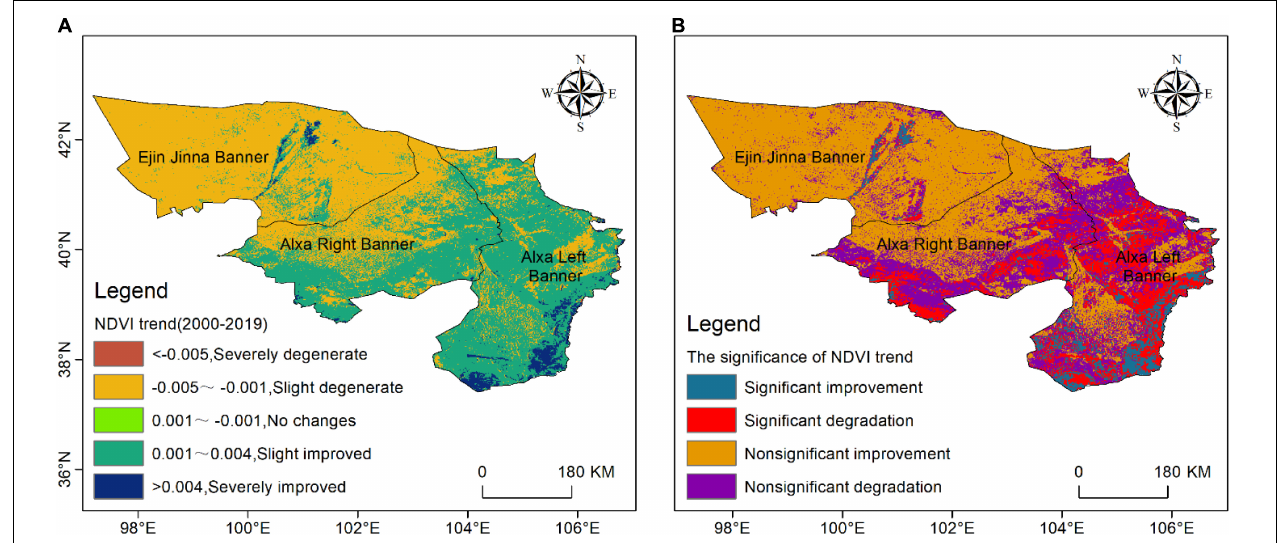
FIGURE 3 | Spatial distribution of interannual NDVI trends and